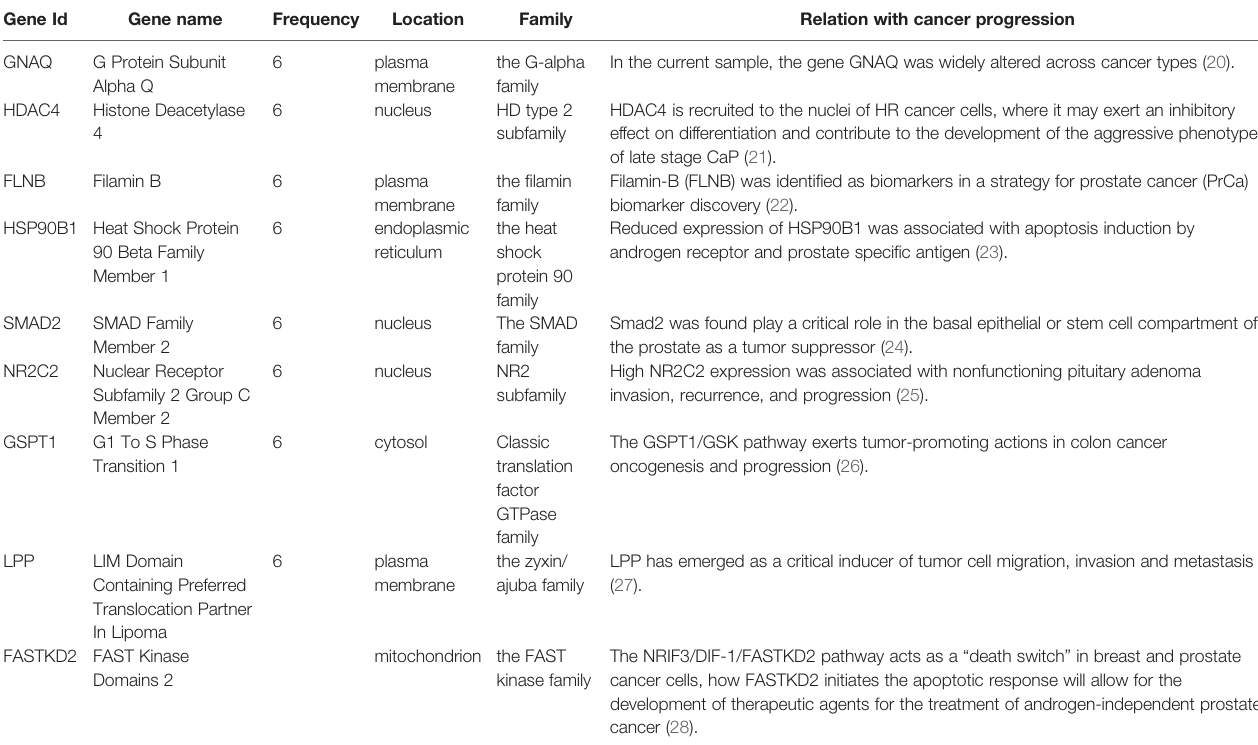
TABLE 1 | The high frequency genes in 6 “ sJSD signal biomarkers ” groups at the critical stage (6th hour) for prostate